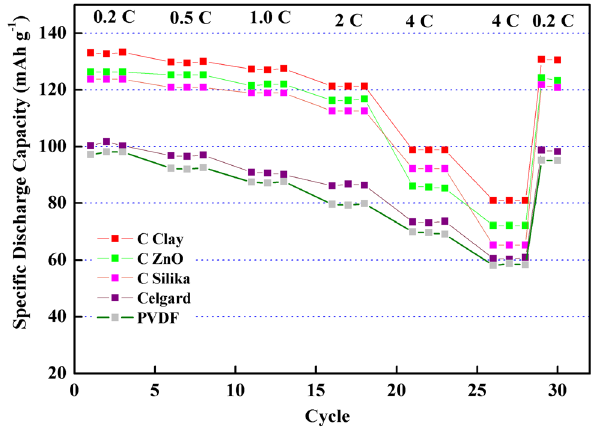
Figure 6: The discharge pro fi les of LiFePO 4 /GPE/graphite full cells at a di ff erent discharge rate